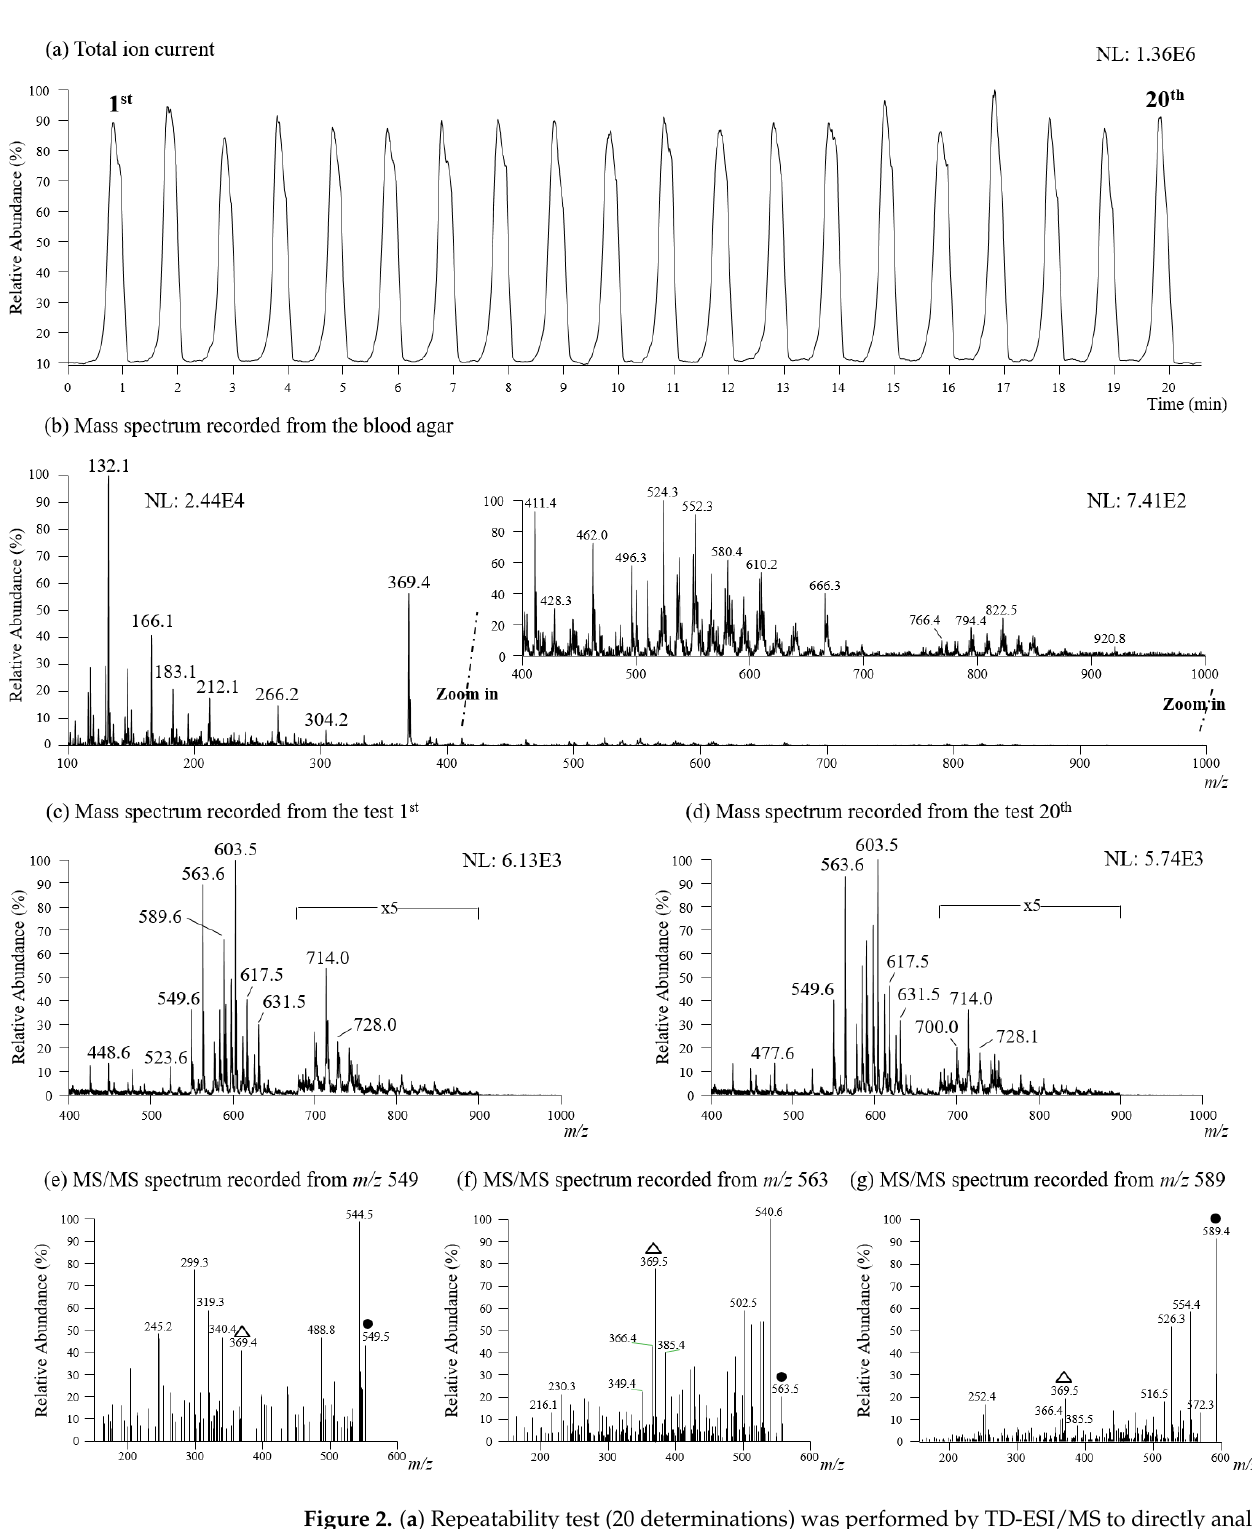
Figure 2. ( a ) Repeatability test (20 determinations) was performed by TD-ESI/MS to directly analyze single colonies of E. coli , a Gram-negative bacterium. ( b ) The mass spectrum of blood agar recorded in positive mode. The lipid ions detected from a single colony of E. coli with ( c ) the 1st ( d ) the 20th test were detected in positive mode. Product ion mass spectra for ( e ) m/z 549, ( f ) m/z 563, and ( g ) m/z 589 recorded from E coli.